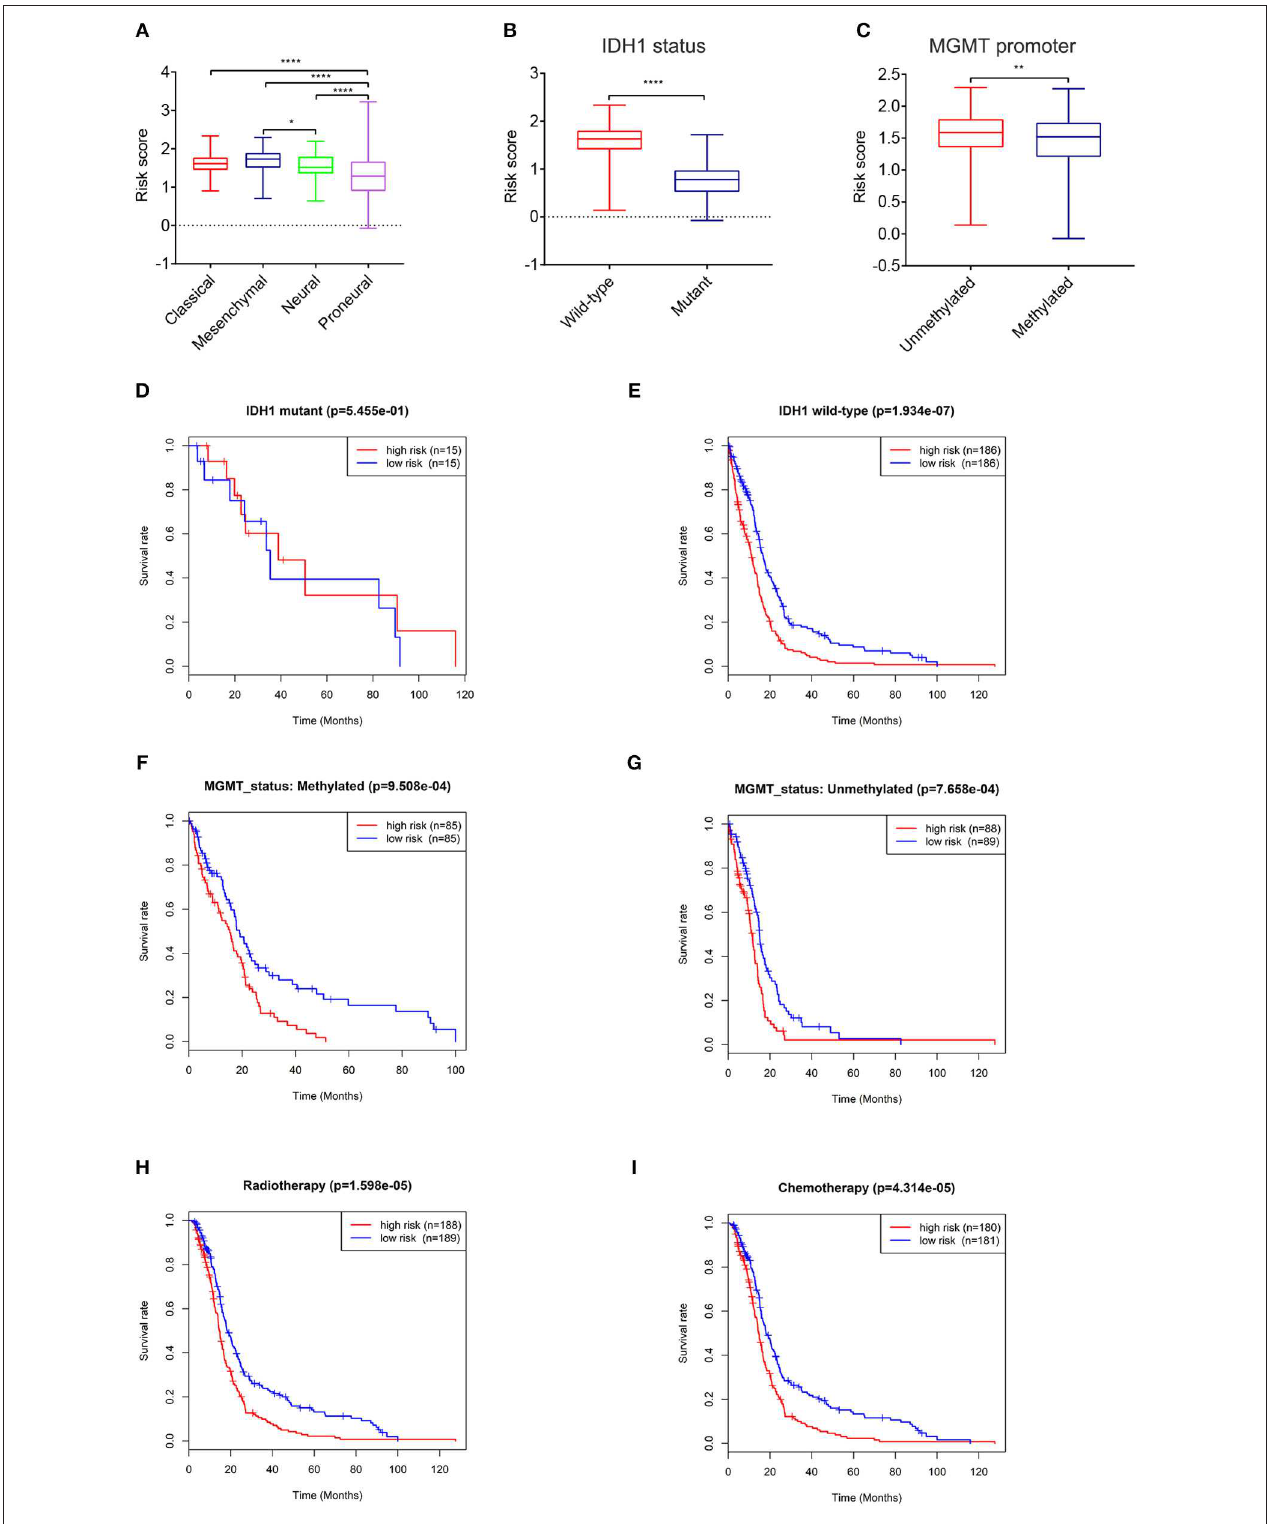
FIGURE 3 | Expression and prognostic significance of the risk signature in different cohorts. Association between the risk signature and different cohorts stratified by molecular subtype (A) , IDH1 (B) , and MGMT status (C) (* P < 0.05, ** P < 0.01, **** P < 0.0001). Prognostic significance of the risk signature in different cohorts stratified by IDH1 status (D,E) , MGMT status (F,G) , radiotherapy (H) , and chemotherapy (I) .